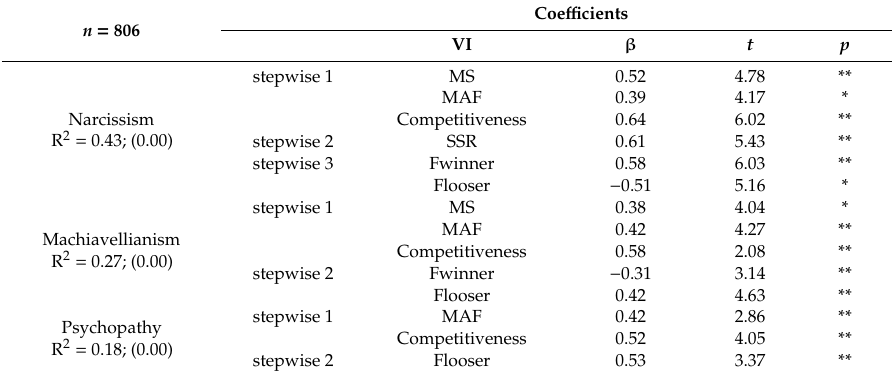
Table 4. Predictive analysis of dark personality traits in athletes, according their